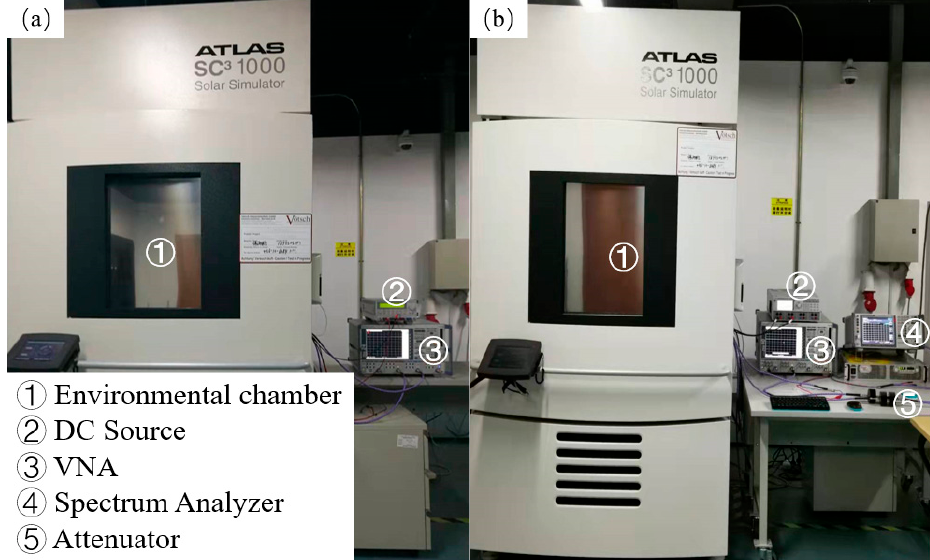
Figure 3. Measurement environment: ( a ) S-parameter; ( b ) output power.